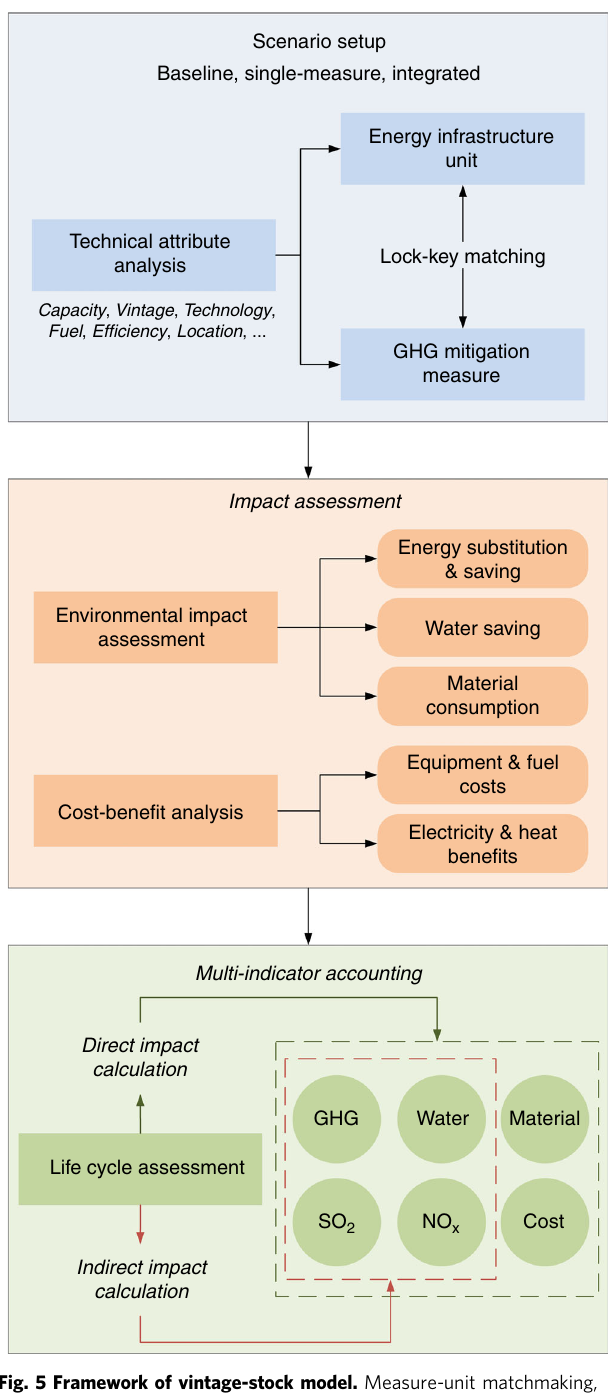
Fig. 5 Framework of vintage-stock model. Measure-unit matchmaking, scenario setup, energy ef fi ciency assessment, GHG emission accounting, cost-bene fi t analysis, and life cycle assessment are integrated in the model to quantify the GHG mitigation potentials, economic costs, and environmental co-bene fi ts of decarbonizing energy infrastructures during their remaining